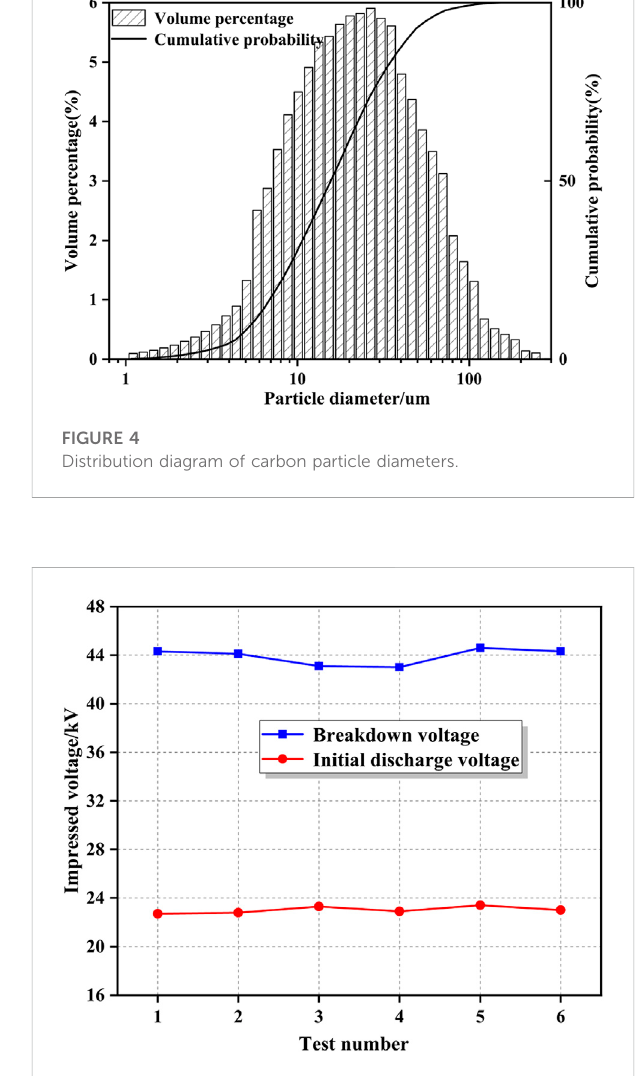
FIGURE 5 Initial discharge voltage and breakdown voltage under pre-